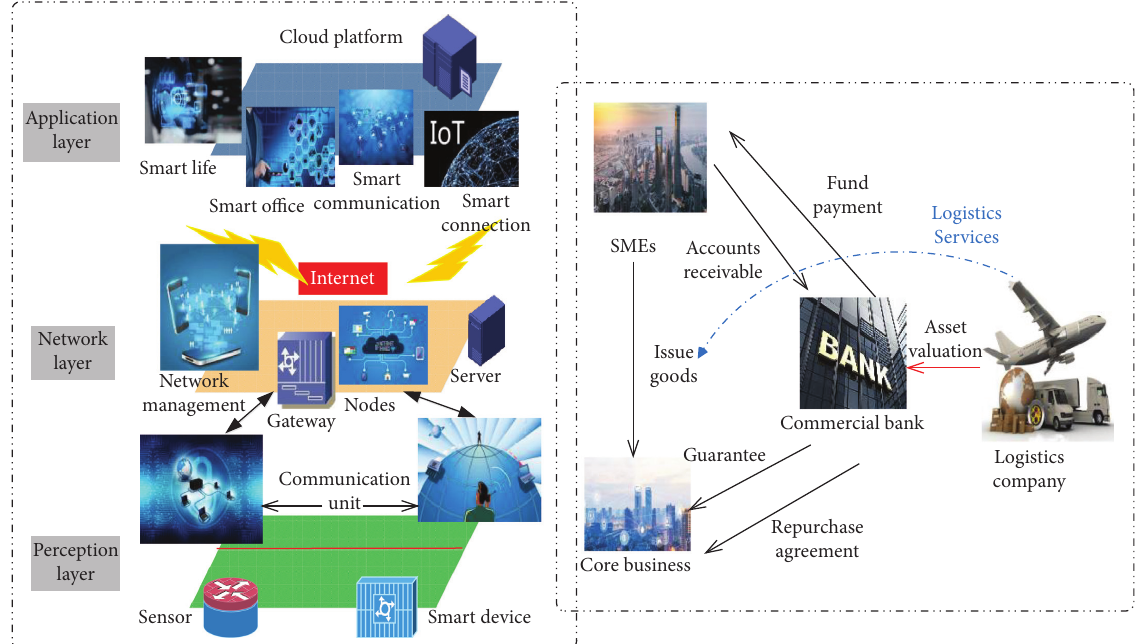
Figure 2: Schematic diagram of accounts receivable financing model under the Internet of Things